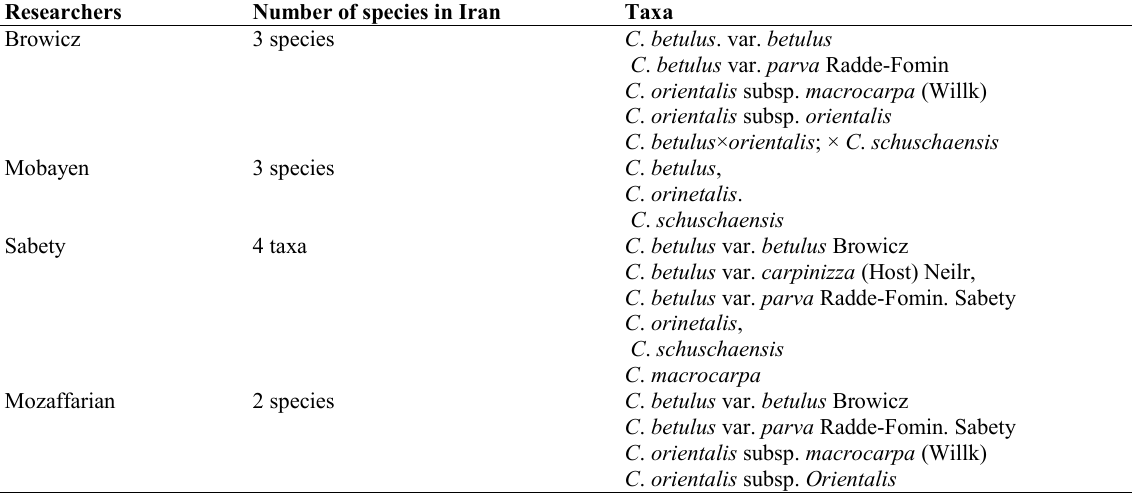
Table 1. Summary of the taxonomical history of Carpinus